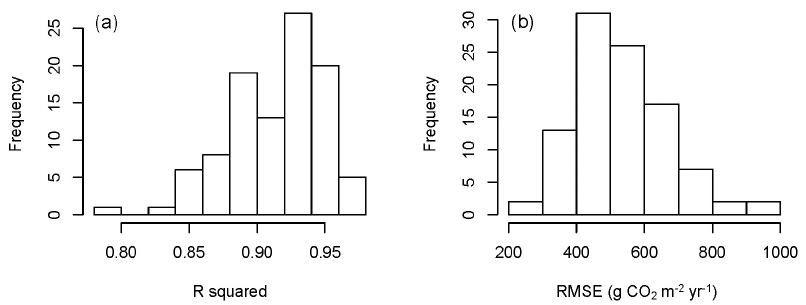
Figure 8. The distribution of R 2 and RMSE values between observed and simulated ecosystem respiration (RECO) using eddy covariance data. ( a ) R 2 between observed and simulated RECO. ( b ) RMSE between observed and simulated RECO.